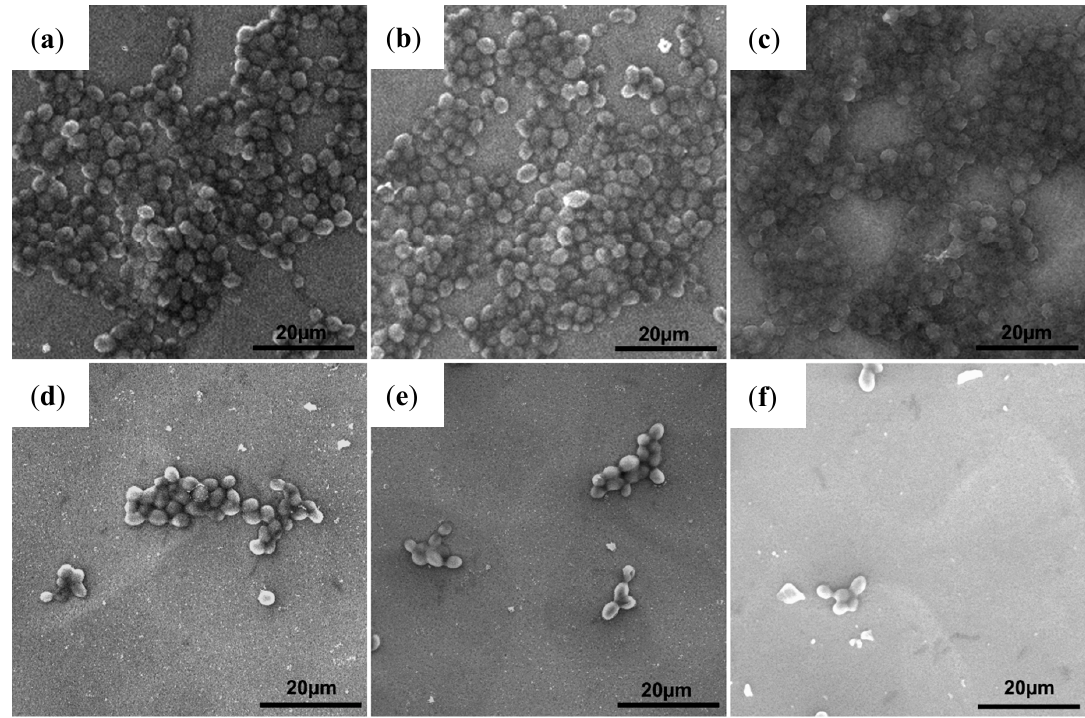
Figure 13. SEM images of Candida albicans ATCC 10231 cell development on HAp ( a – c ) and 5SmHAp coatings ( d – f ) at different time intervals of incubation 24 h ( a , d ) 48 h ( b , e ) and 72 h ( c , f ).